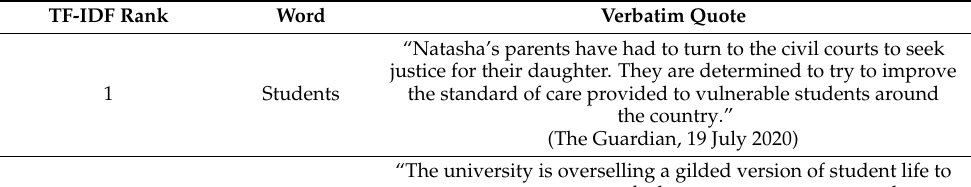
Table 3. Media TF-IDF rank score quote